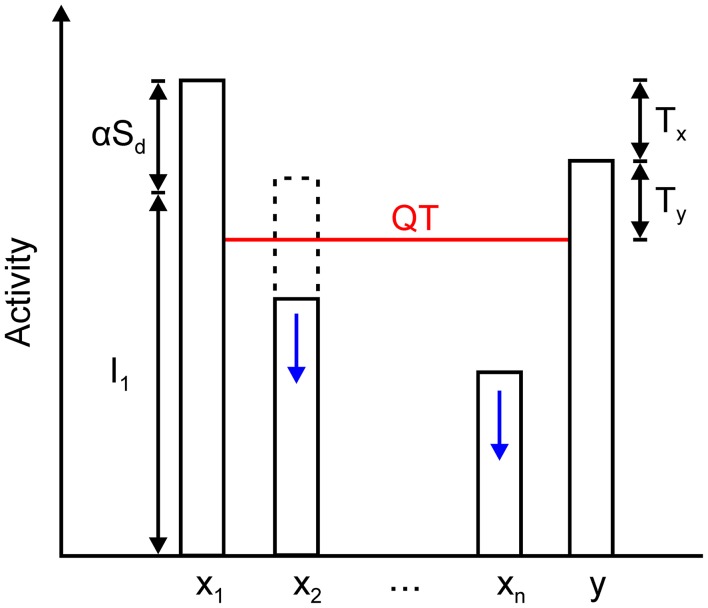
Relationship among the steady state of the winning node x1, inhibitory node y, and all other excitatory nodes in the network, x2 … xn. The activity of the winning node is given by the sum of its feedforward input I1 and the output of its dendrite mediating self- and nearest neighbor excitation, which is expressed as αSd. Inhibitory node y approximately converges to x1 – Tx. It sets the quenching threshold (QT) that separates excitatory nodes into two sets. Nodes x2 … xn are spared from inhibition if their activity is above the QT (dashed line); otherwise, they are silenced to zero (solid line). QT equals y – Ty (or x1 – Tx – Ty) because the activity of the inhibitory node must exceed the threshold on its presynaptic terminals that contact the excitatory nodes.